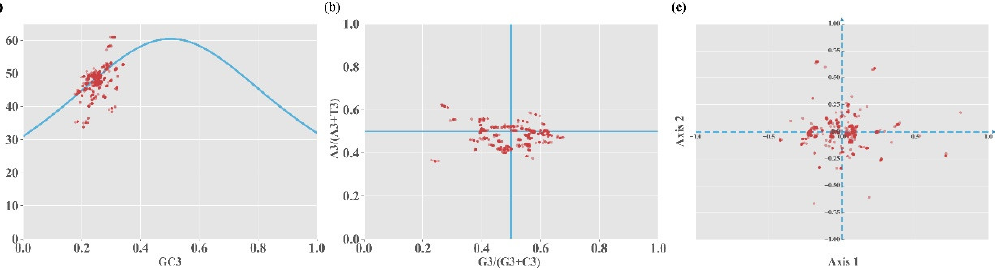
Figure 4. Related plotting analysis of codon usage frequency, with red dots representing protein- coding genes of 36 subg. Cerasus species. ( a ) ENC-plot analysis based on the concatenated coding sequences, the x-axis represents the GC3 value of CDS and the y-axis represents its ENC value; ( b ) PR2-plot analysis, the x-axis denotes the value of G3/(G3 + C3) and the y-axis denotes the value of A3/(A3 + T3); ( c ) correspondence analysis of the RSCU values of subg. Cerasus species, each point on the plot corresponds to the coordinates on the first and second-principal axes produced by the COA.